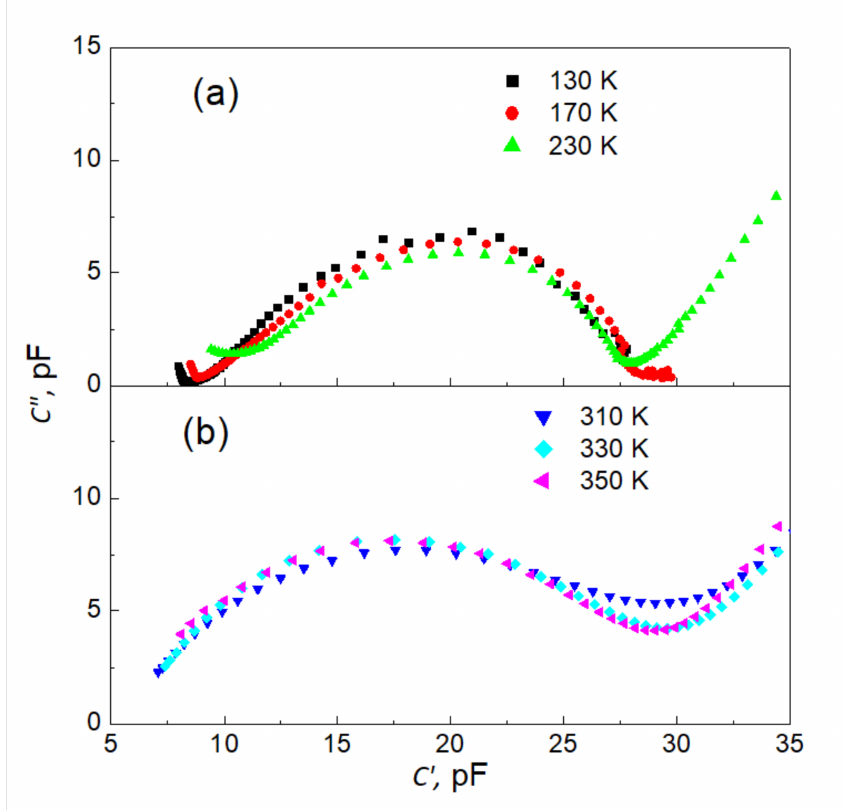
Figure 6. Representatively selected dispersion curves on the complex plane C (cid:48)(cid:48) ( C (cid:48) ) for ferroelectric ( a ) and paraelectric ( b )